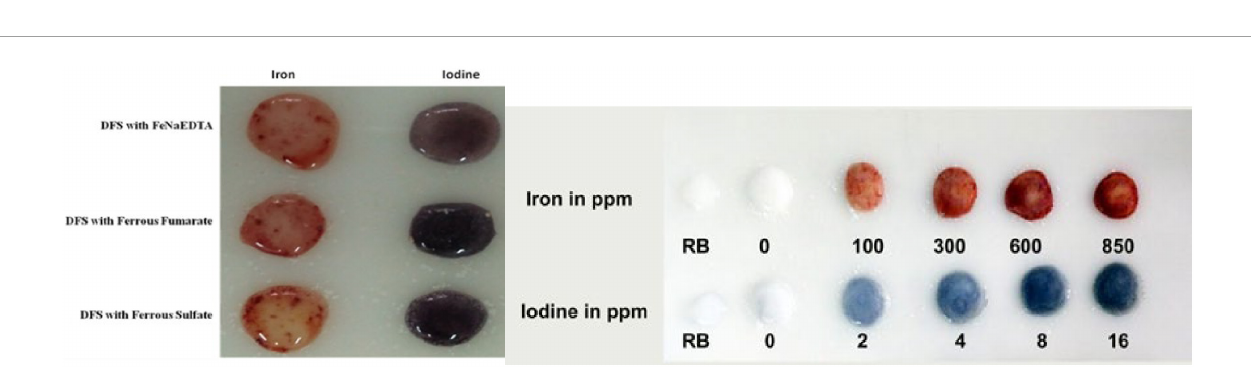
various compounds used for fortification (ferrous as well as